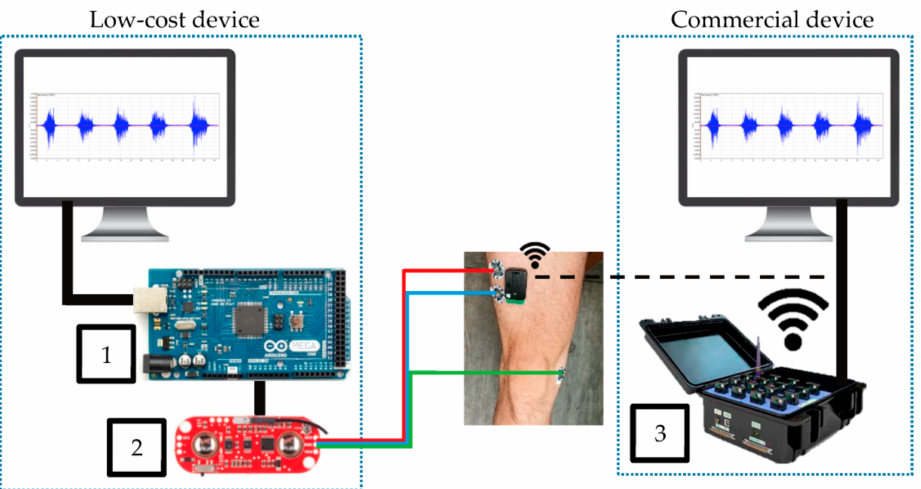
Figure 5. Experimental equipment, comparing Arduino Mega (1) connected to Myoware EMG muscle sensor (2) with a commercial device (3). From [97], originally published under a CC-BY license. Muqueet nevertheless underlined the very small signals in the range of 50 µ V to 1 mV in a broad frequency range of 10 Hz to 3 kHz, making EMG measurements challenging